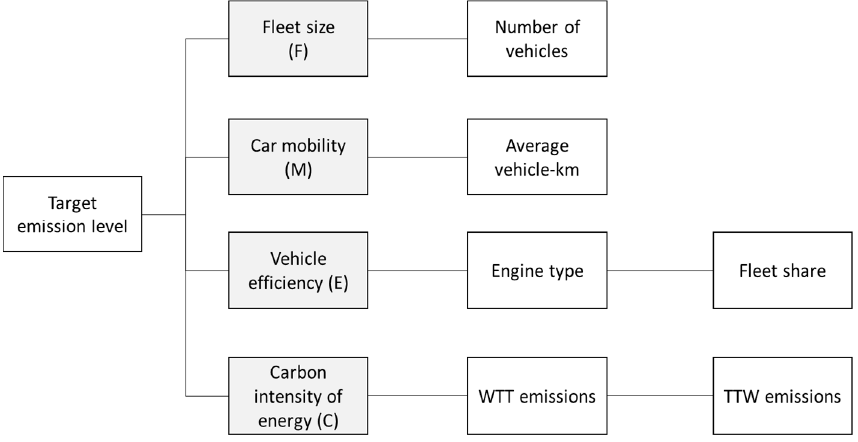
Figure 1. Factors in spreadsheet model to develop decarbonisation scenarios. Note: emission factors in grey boxes, data used to estimate these factors in white boxes. Source: authors’ own illustration.